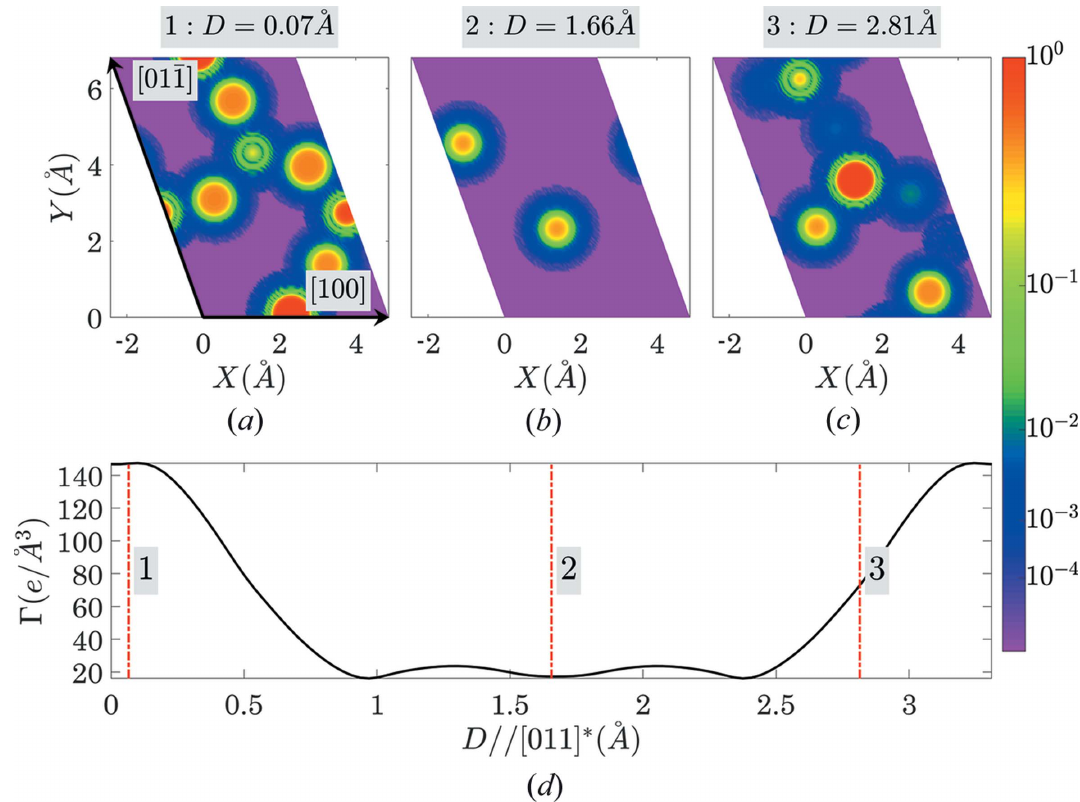
Figure 13 An illustration of the gap location for the case of the (011) plane in quartz. Parts ( a )–( c ) show three electron-density sections by the (011) plane at three various positions of the plane in the unit cell, while ( d ) shows the (cid:2) (011, D ) function with the vertical lines at the positions corresponding to the electron- density sections in ( a )–( c ).